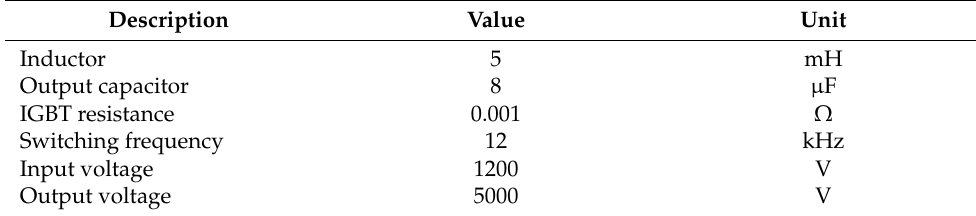
Table A4. BESS parameters (buck–boost